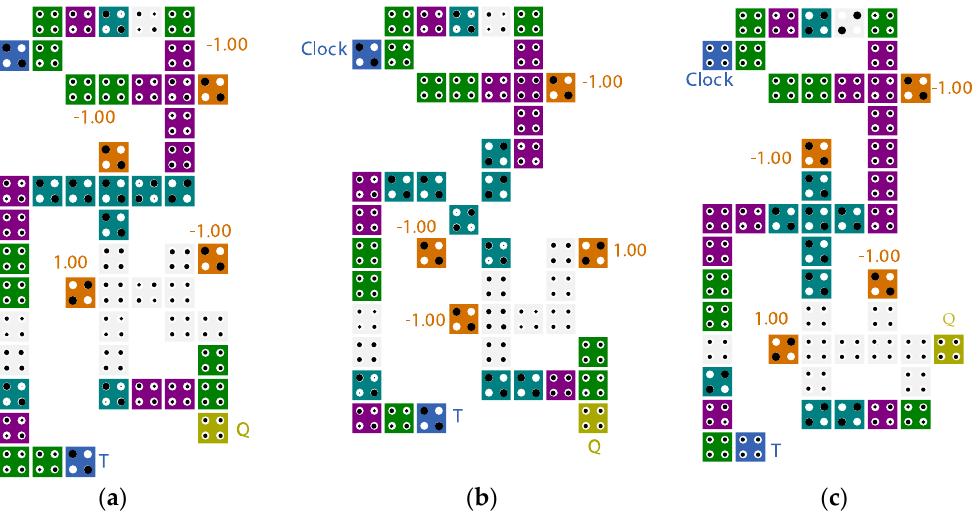
Figure 11. The proposed negative edge-trigger T flip-flops (NET-FFs). ( a ) The first NET-FF (NET- FF1), ( b ) the second NET-FF (NET-FF2), and ( c ) the third NET-FF implemented by using the LST-FF in [16] (NET-FF3).